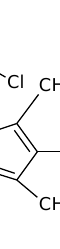
Figure 2. Structure of 2,6-diiodo-1,3,5,7-tetramethyl-8-(2,6-dichlorophenyl)-4,4′-difluoroboradi- 2. Structure of 2,6-diiodo-1,3,5,7-tetramethyl-8-(2,6-dichlorophenyl)-4,4 (cid:48) - azaindacene (BODIPY) used as a photosensitizer (PS). difluoroboradiazaindacene (BODIPY) used as a photosensitizer (PS).